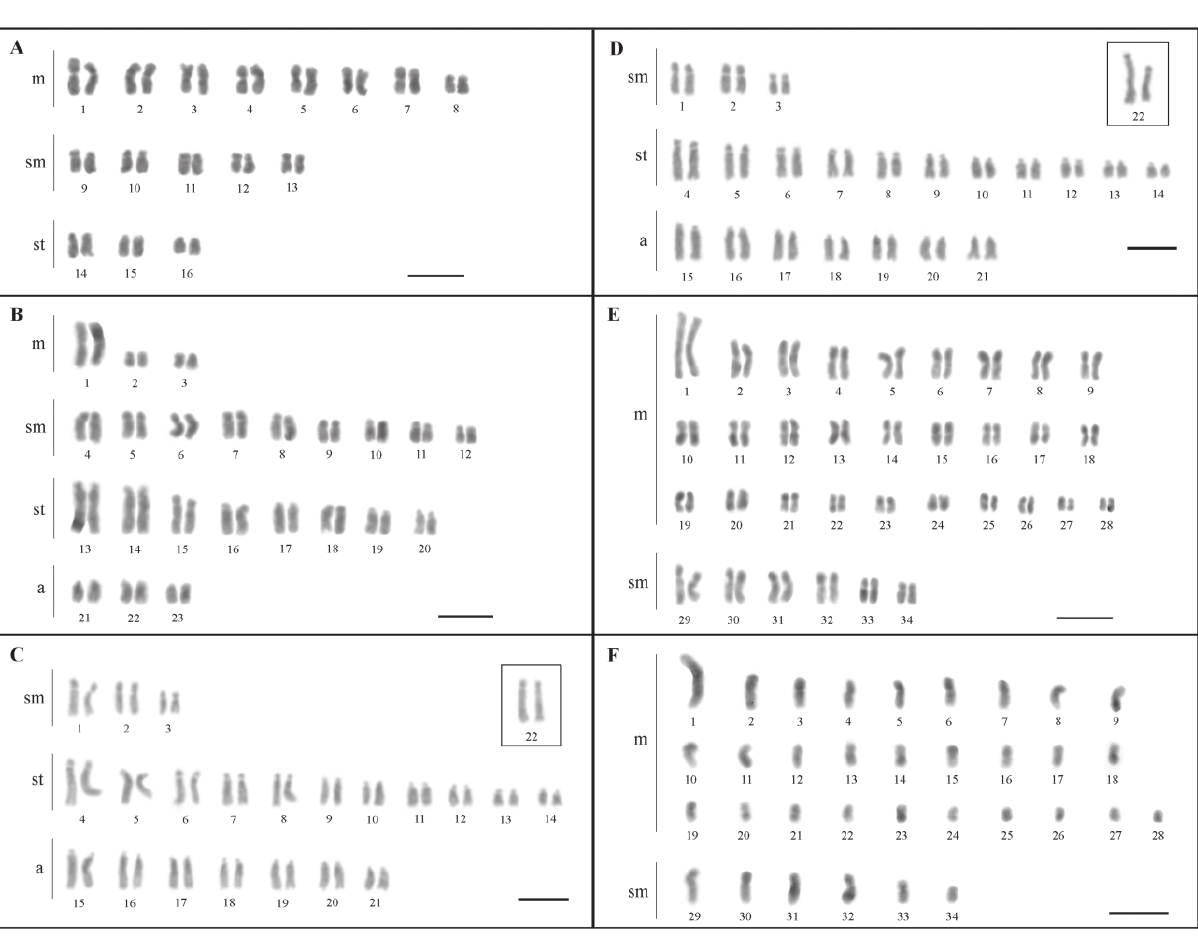
Figure 3. Karyotypes of ant species from subfamilies: Myrmicinae - (A) Wasmannia auropunctata (2n = 32), (B) Apterostigma sp. pilosum complex (2n = 46); Ponerinae - (C), (D) Odontomachus bauri (2n = 44); and Pseudomyrmecinae - (F), (G) Pseudomyrmex unicolor (2n = 68, n = 34). The boxes show polymorphism for subtelocentric chromosome pair 22 in O. bauri : (C) homozygous individual with small arms and (D) heterozygous individual with a distinctive large subtelocentric chromosome. Scale bars = 5